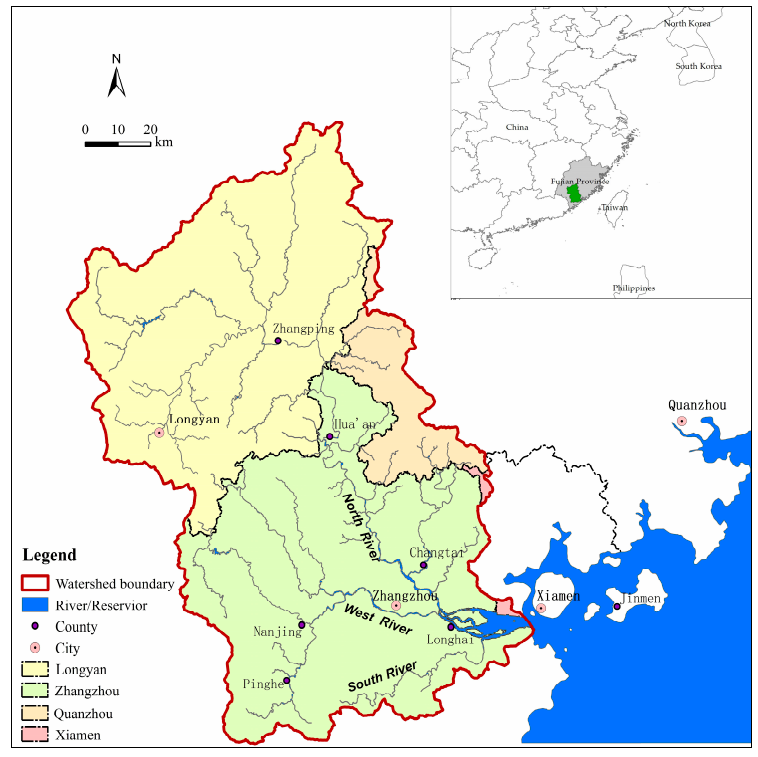
Figure 2. Basic geographical information of the Jiulong River